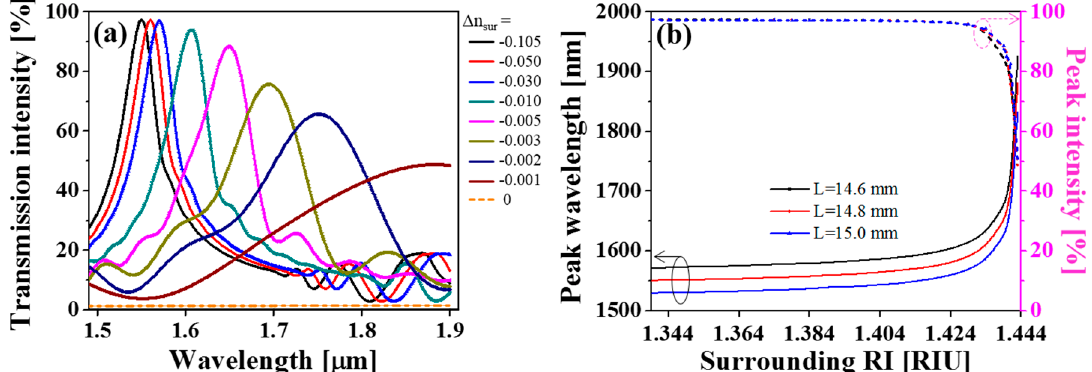
Figure 4. ( a ) Transmission spectra for the sensor under different surrounding RIs for the case of L = 14.8 mm. ( b ) Peak wavelength and peak intensity of the transmission spectra as a function of the surrounding RI for the sensors with L = 14.6 mm, 14.8 mm, and 15.0 mm. Table 2. Sensing performance for the interrogation through wavelength detection. Sensing Range